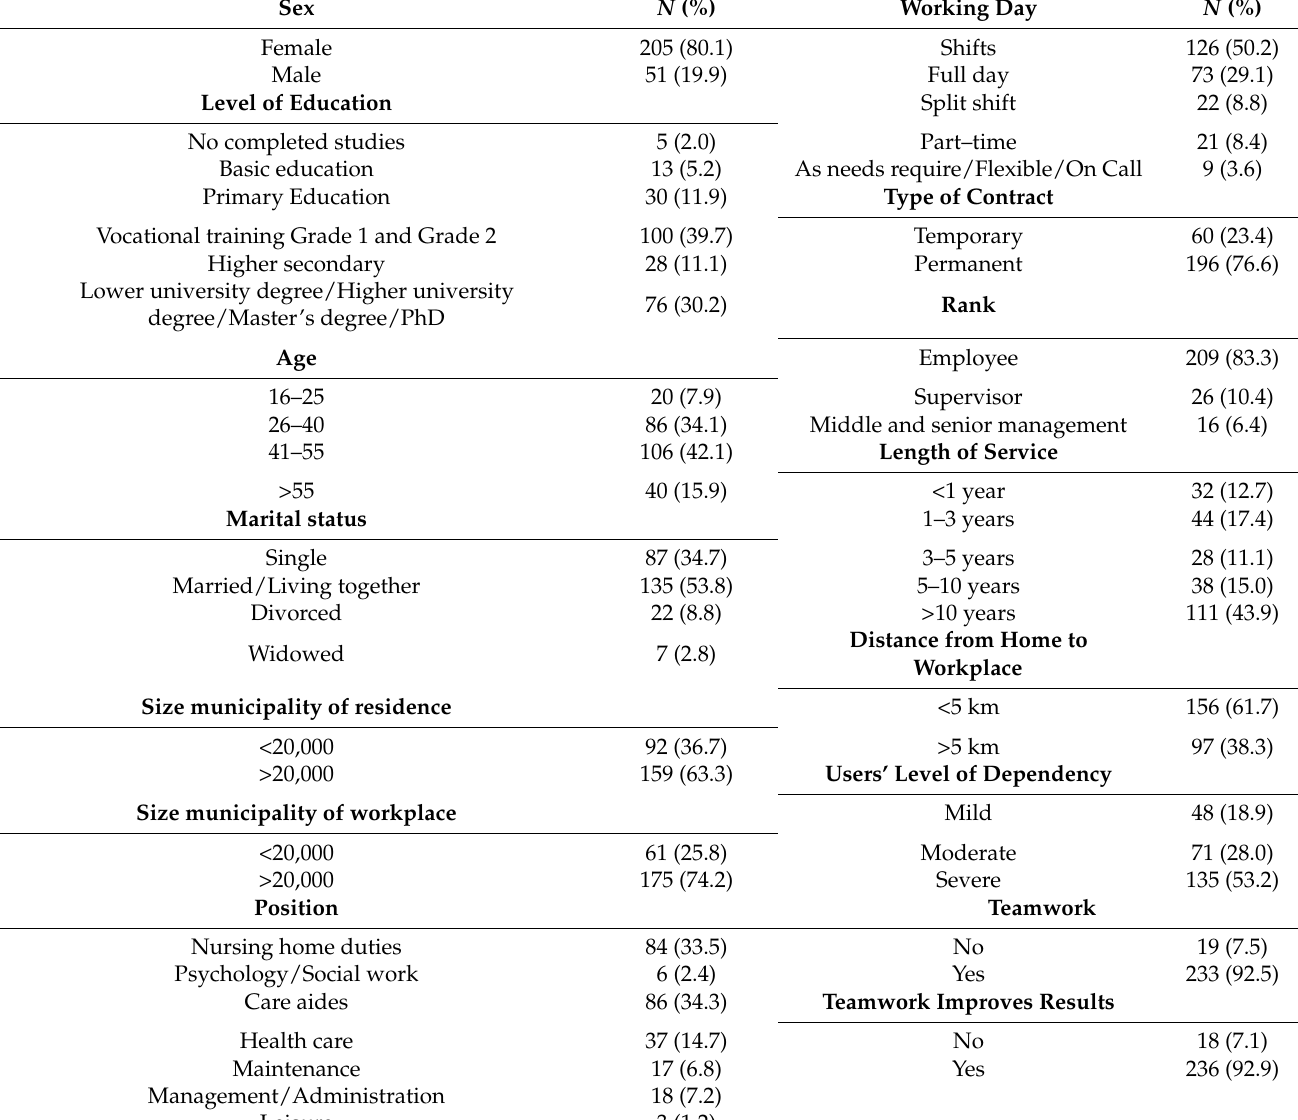
Table 1. Sociodemographic characteristics and working